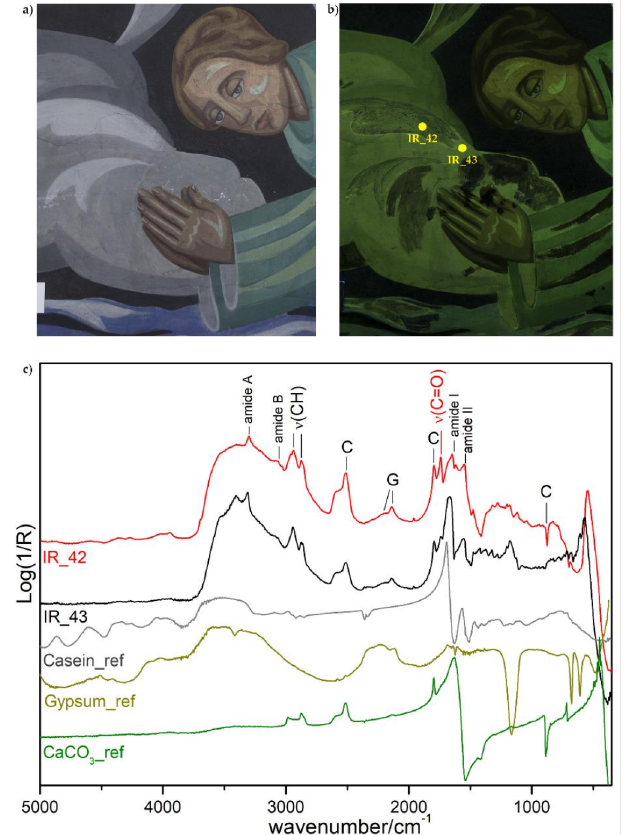
Figure 6. ( a ) Vis and ( b ) UVL images of a detail of cloud and angel (image size ca. 55 cm × 70 cm) in the lower south portion of the Trinity in the apse. ( c ) Reflection FT-IR spectra collected from the points IR_042 and IR_43 (location shown in ( b ) in comparison with reference spectra of casein, gypsum and calcium carbonate). Marker bands of calcium carbonate (C) and gypsum